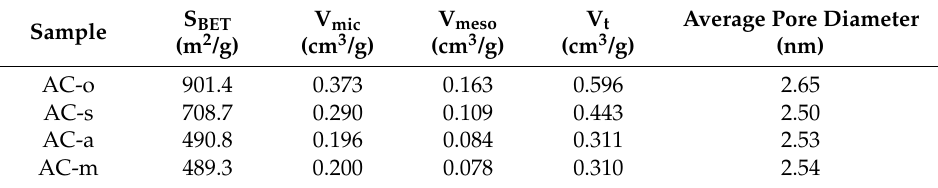
Figure 1. N 2 adsorption/desorption isotherms ( a ) and pore size distributions of the samples using DFT model ( b ).